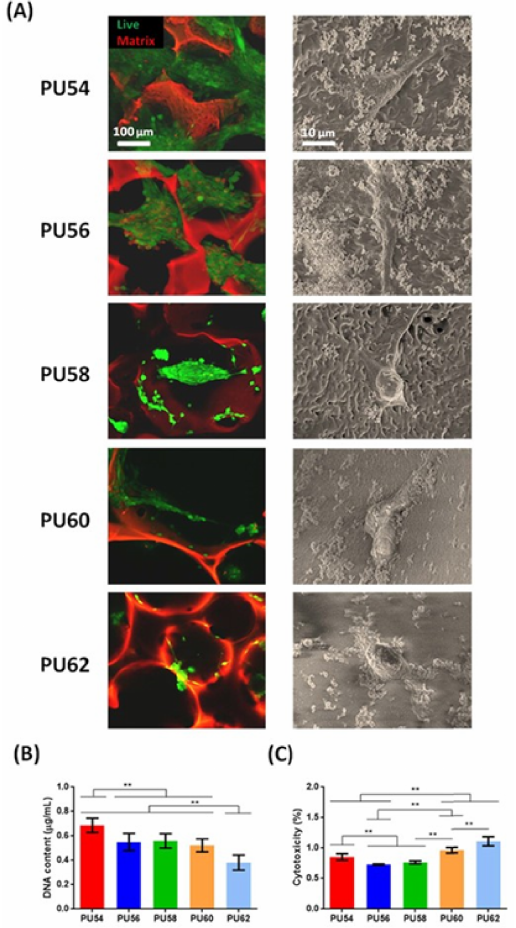
Figure 3. ( A ) Confocal microscopy images ( left ) and correspondent SEM images ( right ), of C2C12 skeletal muscle cultured on PU-based scaffolds. In fluorescence images, live cells are shown in green, while the scaffold matrix is shown in red. ( B ) DNA quantification for C2C12 skeletal muscle cells on each sample type, 24 h after seeding. ( C ) Cytotoxicity expressed as the ratio between the lactate dehydrogenase (LDH) released from cells cultured on the samples and the one released from a positive control featured by relevant toxicity, 24 h after seeding. Reprinted from [64] with permission from